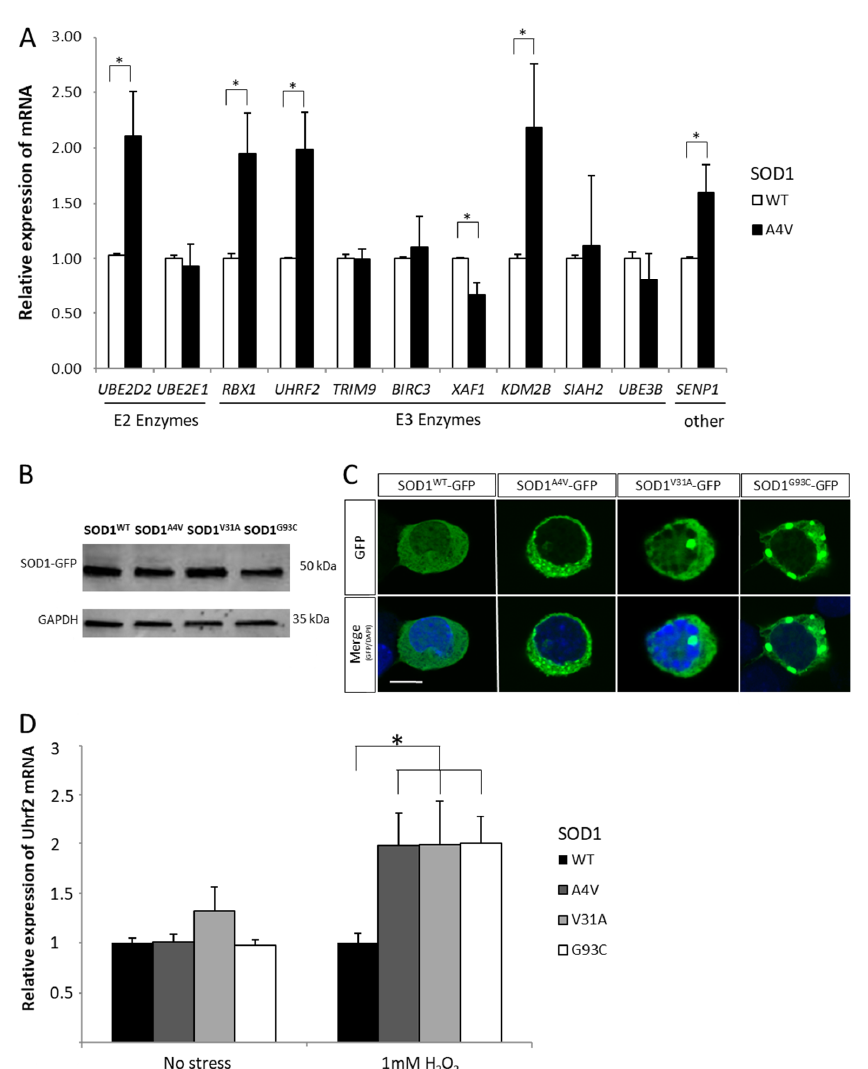
Figure 2. ( A ) Relative mRNA expression of Ube2d2, Ube2e1, Rbx1, Uhrf2, Trim9, Birc3, Xaf1, Kdm2b, Siah2, Ube3b, and Senp1 in NSC-34 cells expressing SOD1 WT or SOD1 A4V in presence of 1 mM of H 2 O 2 for 3 h. ( B ) Western blotting of SOD1-GFP proteins in NSC-34 cells expressing SOD1 WT -GFP, SOD1 A4V -GFP, SOD1 V31A -GFP, and SOD1 G93C -GFP using antibodies against GFP or Gapdh. ( C ) Confocal microscopy analysis of SOD1 WT – GFP or SOD1 mutant -GFP in NSC-34 showing aggregates (48 h post-transfection). Scale bar: 30 µm. ( D ) Relative mRNA expression of Uhr2 in NSC-34 cells expressing SOD1 WT , SOD1 A4V , SOD1 V31A , and SOD1 G93C in absence or presence of 1 mM of H 2 O 2 for 3 h.* p < 0.05.